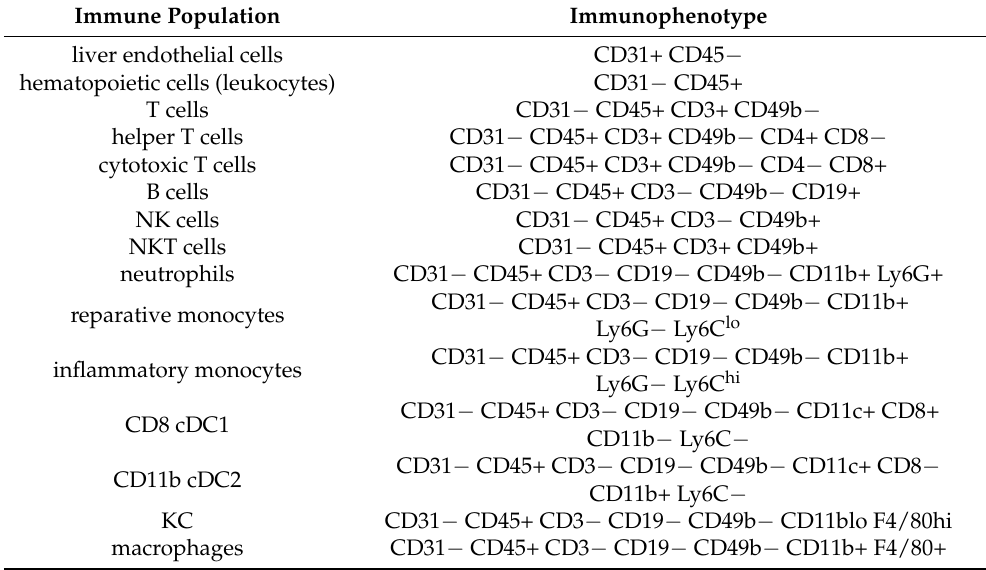
Table 2. Phenotypes of particular immune